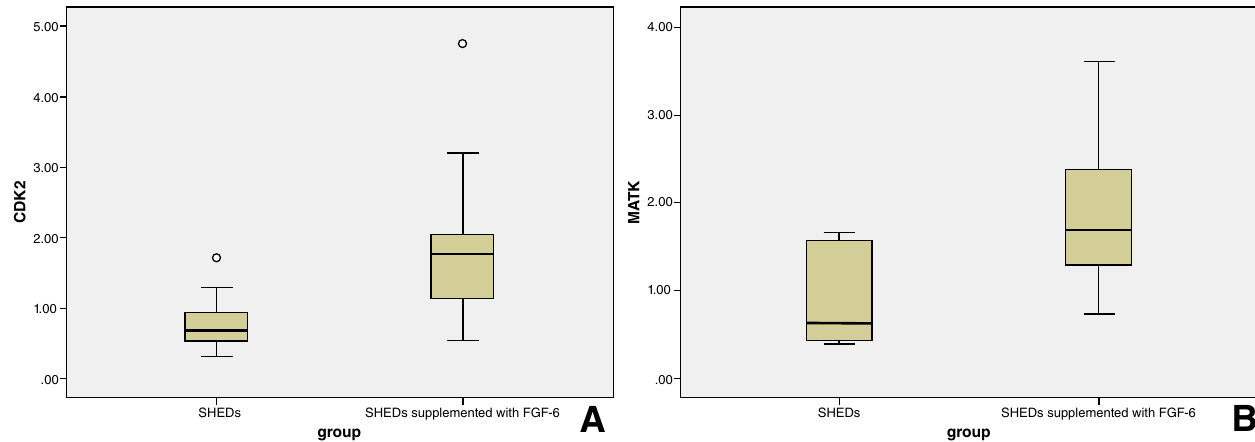
Figure 3. Box-and-whiskers plot showing number distribution for CDK2 and MATK expression in both test and control groups. ( A and B ) Expression of each gene is higher in the FGF-6-supplemented group than in the control group, since higher interquartile range (IQR) and median values are observed.